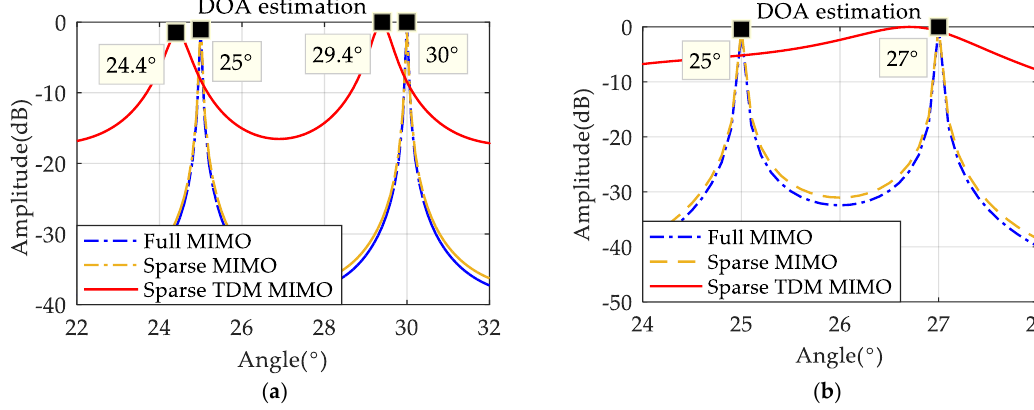
Figure 8. ( a ) DOA performance comparison for motion targets; ( b ) Angular resolution contrast of targets DOA estimation results for motion targets.